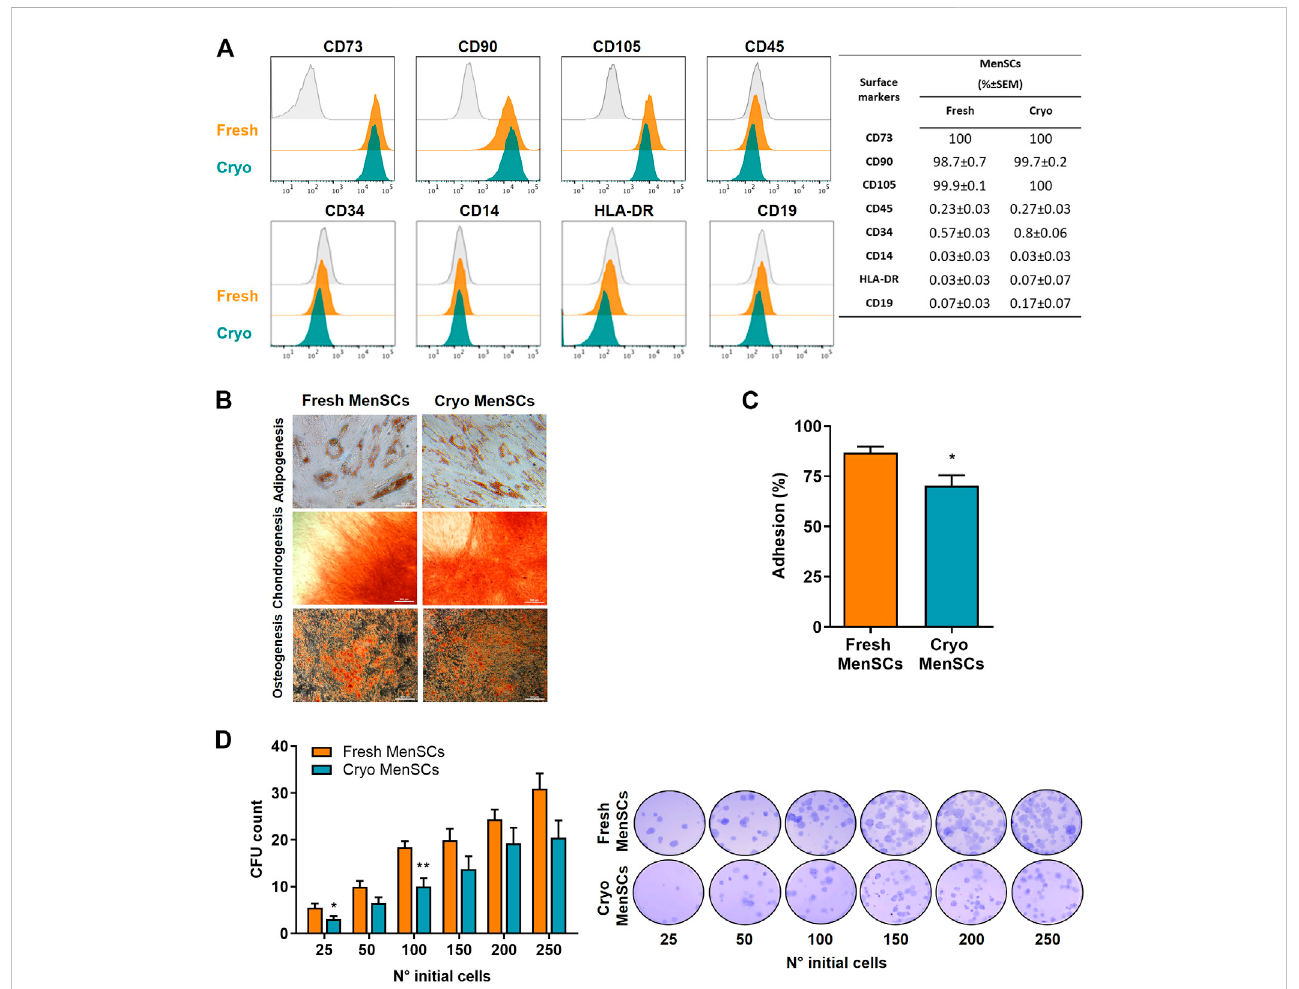
FIGURE 2 Comparison studies of cryopreserved and fresh MenSCs: immunophenotype, differentiation capacity, colony-forming unit potential, and adhesion. The analyses were performed with cryopreserved and thawed cells (cryo-MenSCs) compared with fresh culture cells (fresh MenSCs). (A) Flow cytometric analysis of MenSCs surface markers. Representative histograms of positive (CD73, CD90, and CD105) and negative (CD45, CD34, CD14, HLA-DR, and CD19) markers (orangeandgreenlines)andtheauto fl uorescencecontrolfromfreshMenSCs(greyline).Viablecellsweredeterminedusingavitaldye(LIVE/DEAD).The quantity ofeach markerisshown in thetable. (B) MenSCs displayedmesodermaltri-differentiation capacity. Representative imagesof MenSCs differentiation after speci fi c induction media and staining for adipocytes (Oil red O), chondrocytes (Safranin O), and osteocytes (Alizarin Red). (C) Adhesion to the plastic or cellculturesurfaceofMenSCsafter24 hinculture. (D) Quanti fi cationofcolony-formingunits(CFU)ofMenSCs.Cellswereseededattheindicatednumberin complete medium and cultured for 14 days. Representative images of fi xed and stained cultures are shown on the right. Values are expressed as the mean ± standard error of the mean (SEM) of three different MenSCs donors and at least three independent experiments; * p ≤ 0.05 and ** p ≤ 0.01 (Cryo vs.